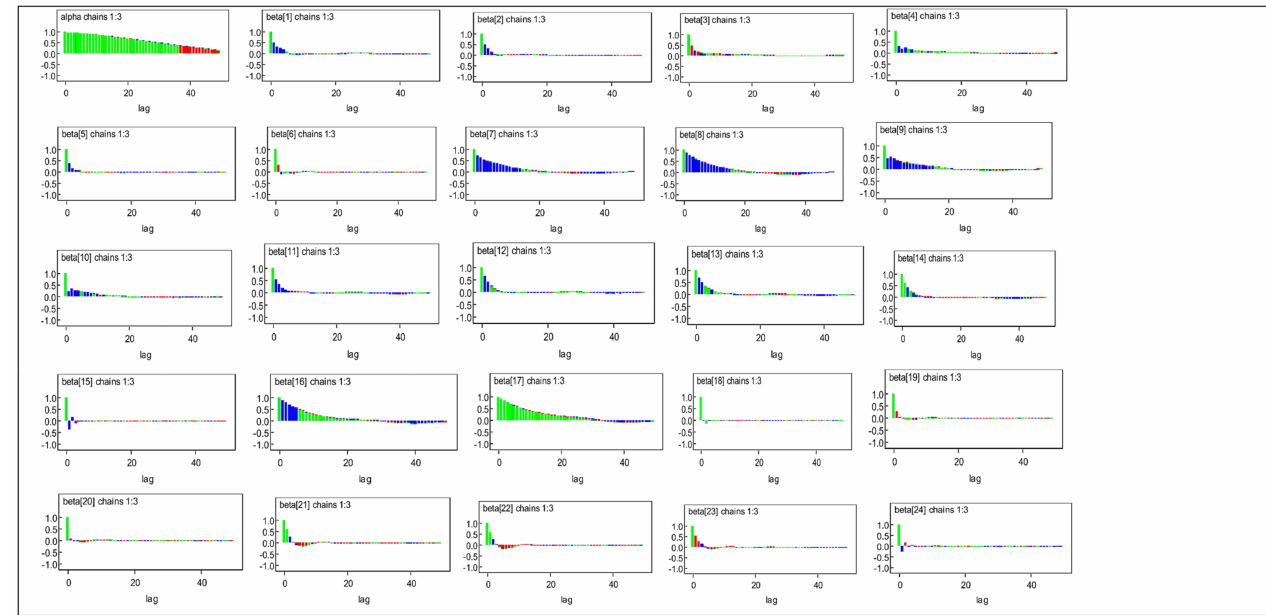
Figure A3. Autocorrelation plots for Bayesian MLM with non-informative